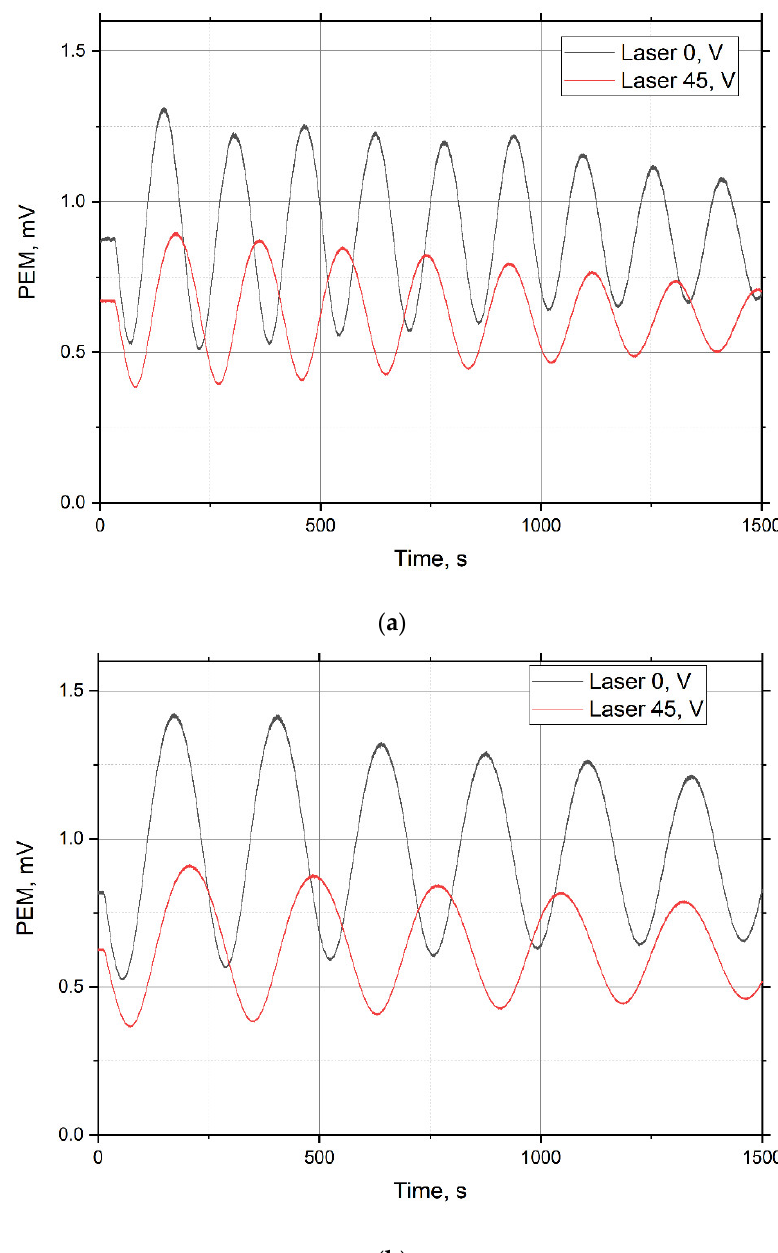
Figure 5. Interference patterns during the deposition of mixture of water and nitrogen ( a ) and mixture of water and argon ( b ). α 1 = 1°, α 2 =